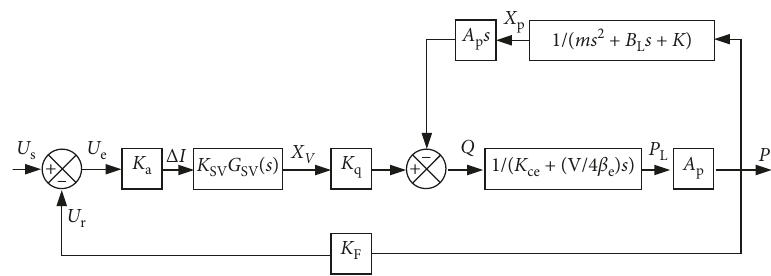
Figure 4: Transfer function block diagram of the force control